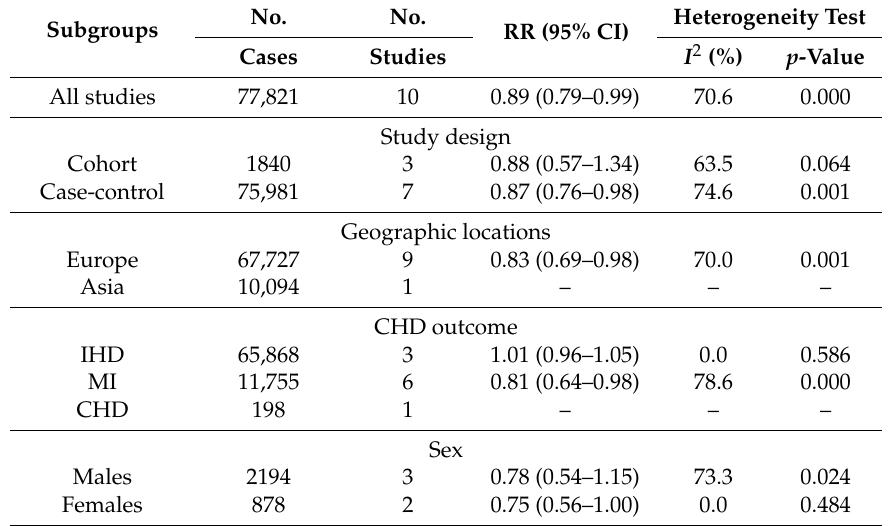
Table 2. Summary risk estimates of the levels of magnesium in drinking water and CHD mortality